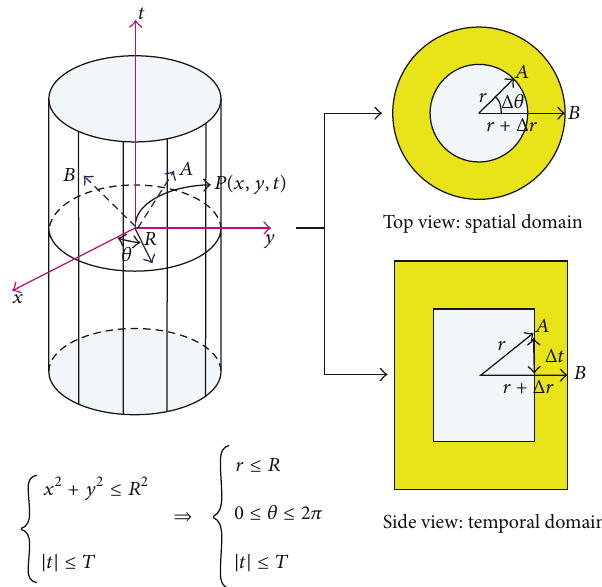
Figure 5: Schematic for the calculation of spatiotemporal Weber variation feature. 𝑃(𝑥,𝑦,𝑡) is the center of the cylindroid spatiotem- poral volume; 𝐴 : 𝑃 𝐴 (𝑟,𝜃, 𝑡) and 𝐵 : 𝑃 𝐵 (𝑟+Δ𝑟,𝜃+Δ𝜃,𝑡+Δ𝑡) are two arbitrary pixels in the